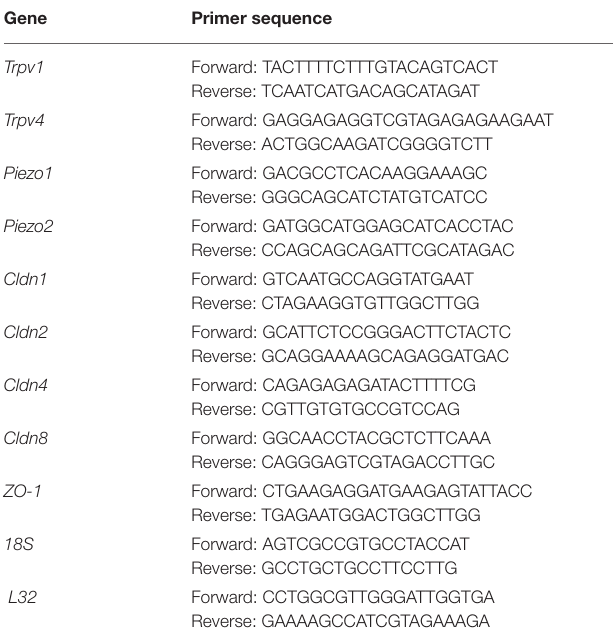
TABLE 1 | Sequences of forward and reverse primers for 9 genes of interest and 2 housekeeping genes used for RT-qPCR